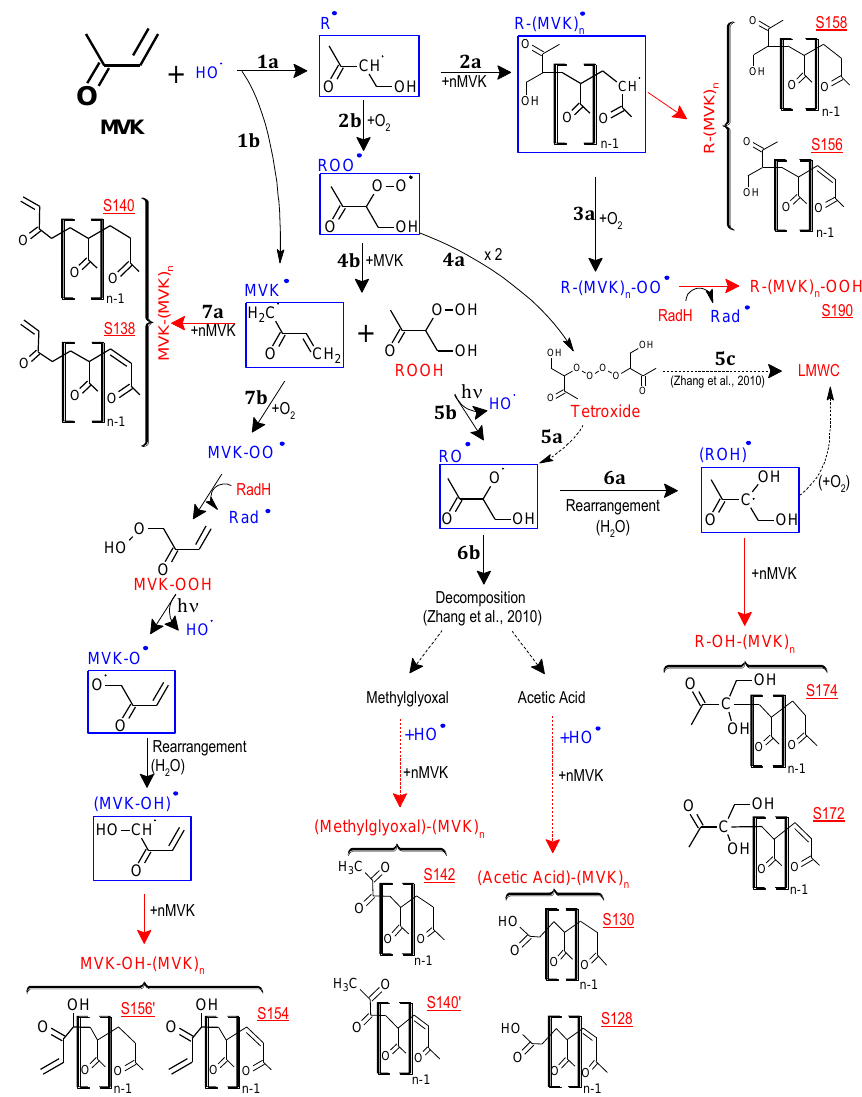
Fig. 10. Proposed scheme of the chemical mechanism of OH-oxidation of MVK in the aqueous phase with implementation of radical oligomerization pathways (for clarity, only external OH-addition on MVK is developed). RadH = MVK, HO • (in red). Radicals (in blue). LMWC: low-molecular-weight